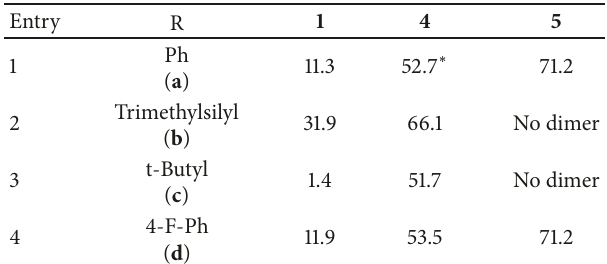
Table 3: 31 P NMR chemicalshifts (ppm) (CDCl 3 ) of 4 and 5 ( ∗ done in acetone-d 6